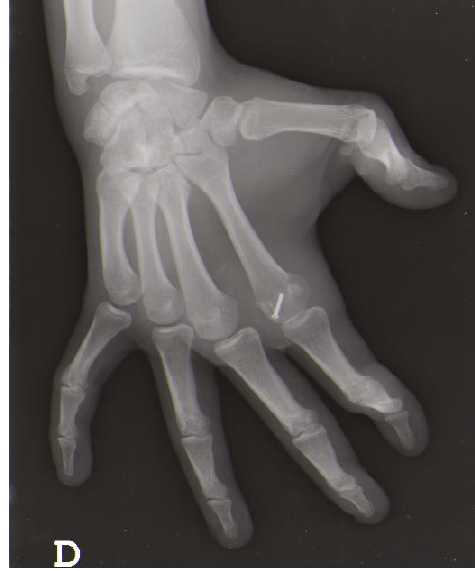
Figure 8: X-Ray (lateral view) showing fracture consolidation at week